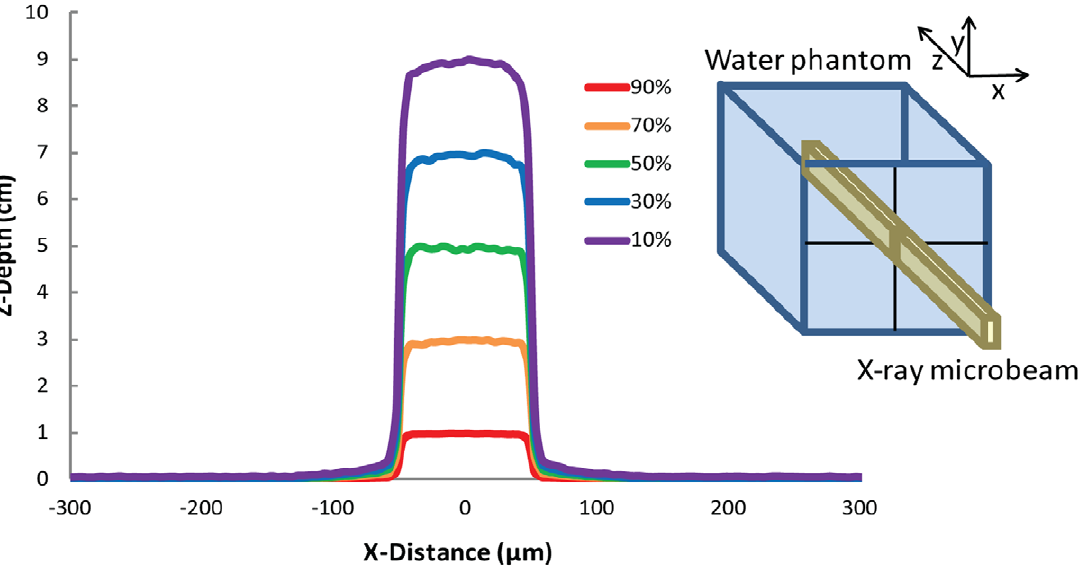
Figure 1. Isodose curves deposited by a microbeam. Dose profiles deposited in a 16 6 16 6 16 cm 3 water phantom by a single 100 m m wide and 10 mm high X-ray microbeam of 100 keV (Monte Carlo simulations), i.e. of energy similar to the median energy of the used spectrum (inset), propagating along the z direction The 50% of the dose is deposited at about 5 cm depth. Objects are not to scale.